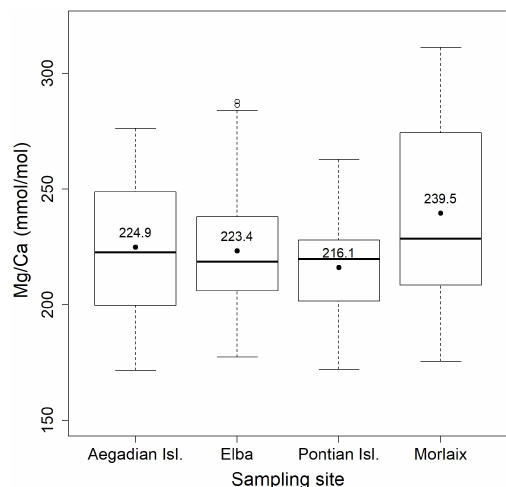
Figure 4. Box plot of the statistical tests performed to evaluate the differences of Mg / Ca in L. corallioides collected at different sam- pling sites. The horizontal black lines indicate the median values. The black dots and the numbers inside the plot indicate the mean